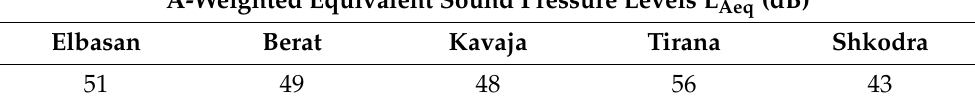
Table 3. Background noise